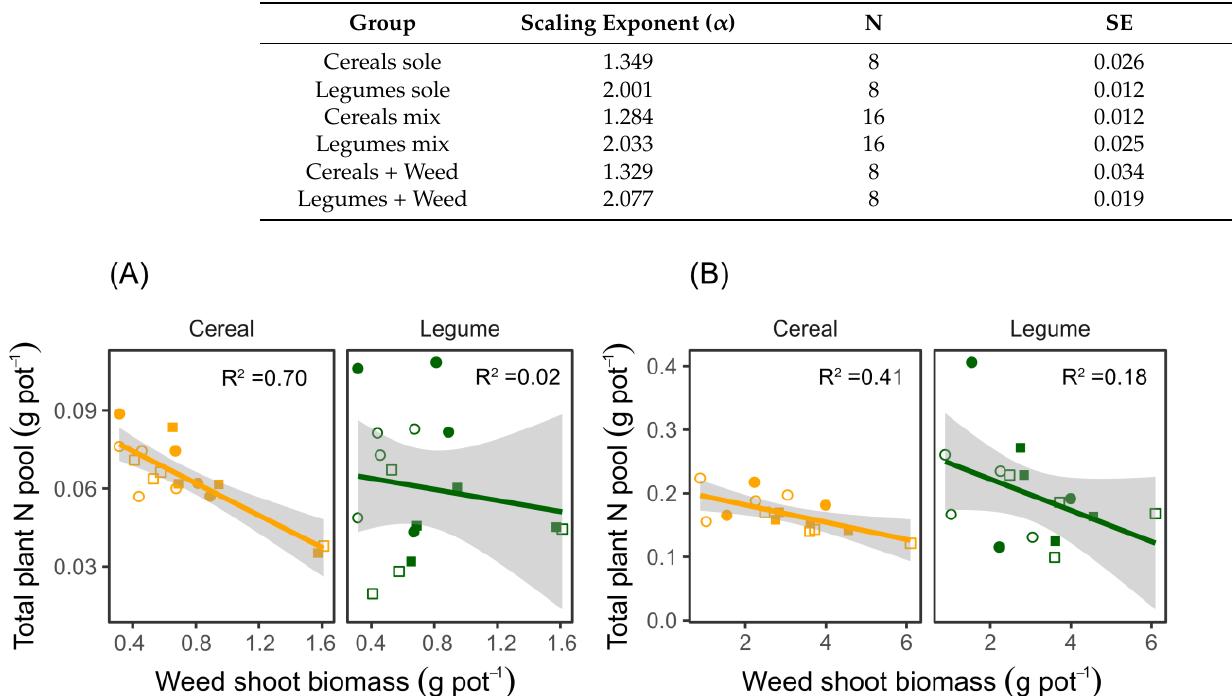
Figure 4. Relationships between total plant N pools and weed shoot biomasses for the cultivars of cereals and legumes pot-grown in mixtures and with the weed C. album . The plants were sampled at ( A ) flowering and ( B ) maturity. Both cultivars of cereals and legumes were considered in the analysis. Open and closed square symbols represent ‘Boxer’–‘Alderon’ and ‘Boxer’–‘Diskett’ cultivar mixtures, respectively, while open and closed circles represent ‘Fuego’–‘Alderon’ and ‘Fuego’–‘Diskett’ cultivar mixtures, respectively. Lines indicate linear regressions at crop flowering: cereals y= 0.087–0.031x and legumes y = 0.068–0.011x with p ≤ 0.001 and p = 0.567, respectively; and at maturity: cereals y = 0.21 – 0.014x and legumes y = 0.27 – 0.025x with p < 0.0098 and p = 0.108, respectively.